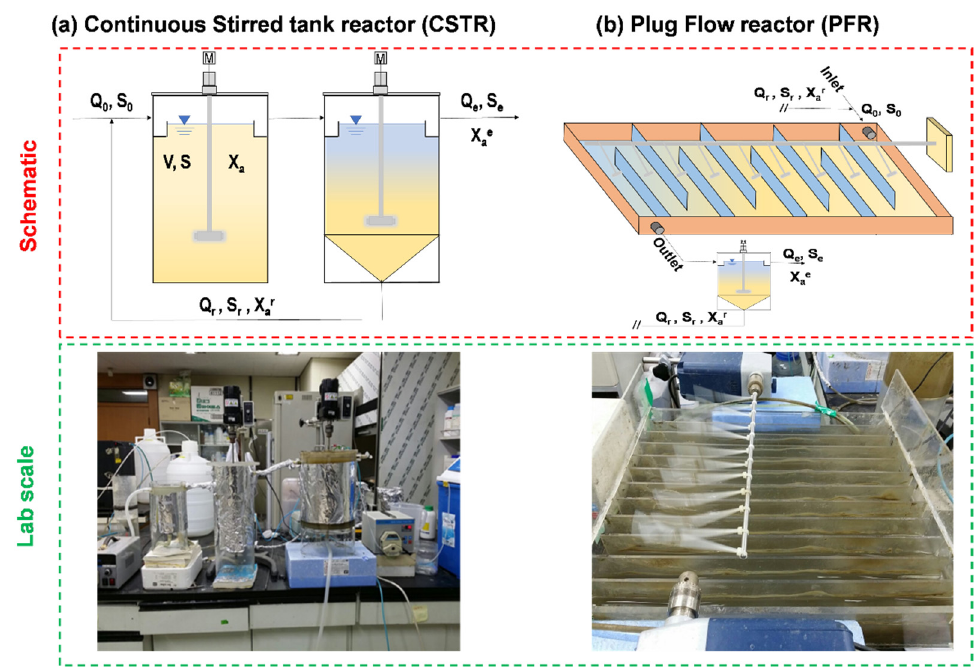
Figure 2. Overview of the lab-scale reactor setups with a schematic for the biodegradation of 1,4– dioxane: ( a ) CSTR and ( b ) PFR .